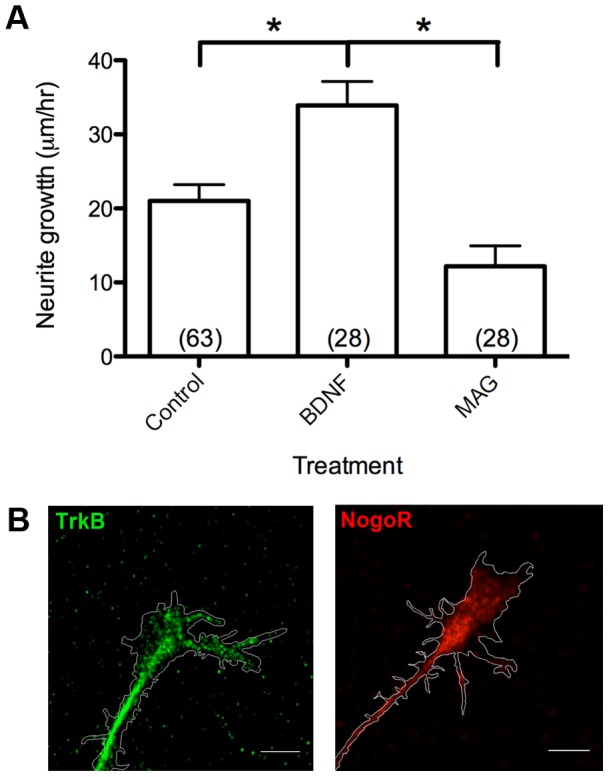
Positive and negative mammalian cues regulate axonal outgrowth.(A) Treatment with BDNF promotes while MAG inhibits axon outgrowth. (B) Staining with antibodies to mammalian BDNF receptor TrkB and MAG receptor NgR reveals high immunoreactivity at spinal neuron growth cones. Scale bar, 5 µm. *, p<0.05.